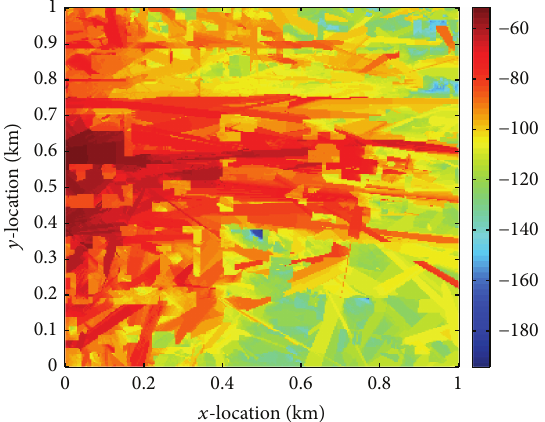
Figure 4: Simulated received power (dBm) data from the MCD for downtown State College, PA, for Scenario A. Data plotted for the dominant multipath.